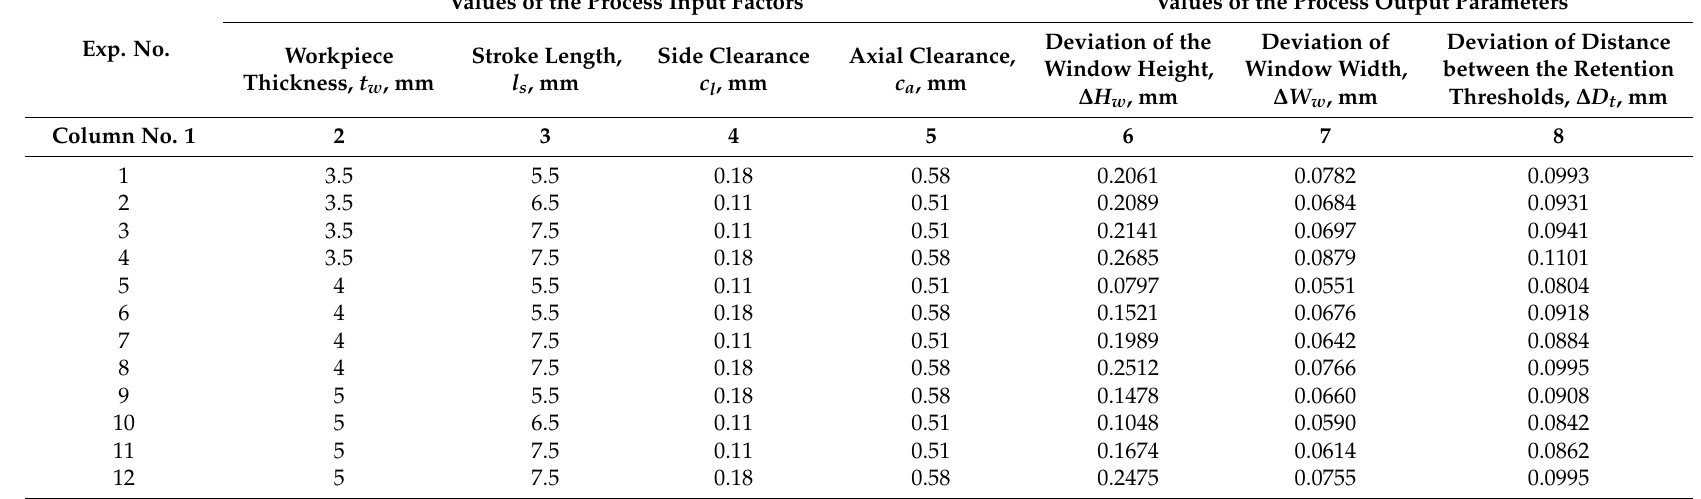
Table 1. Experimental conditions and